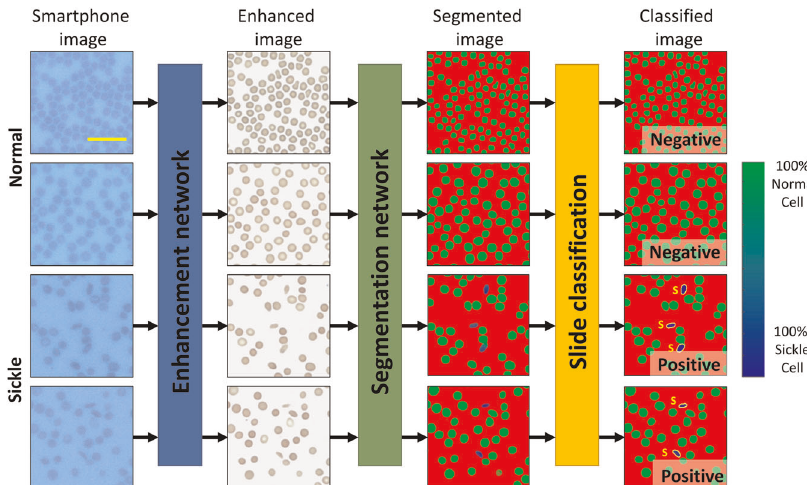
Fig. 2 Example image patches. Demonstration of various test image patches that passed through the various steps of the automated sickle cell analysis framework. The smartphone microscopy images are fi rst passed through an image enhancement and standardization network. Following this step, the images are segmented using a second, separate neural network. This segmentation network is in turn used to determine the number of normal and sickle cells within each image; fi ve fi elds-of-view together covering ~1.25 mm 2 is automatically screened, having on average 9630 red blood cells to make a diagnosis for each patient blood smear. Scale bar indicates 20 μ